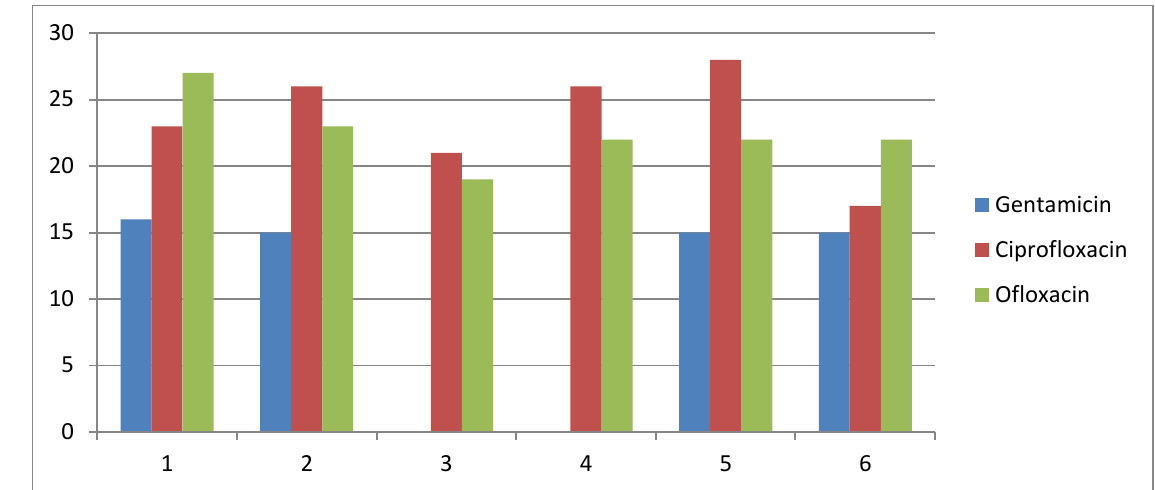
Figure 1. Antibiotics sensitivity test.